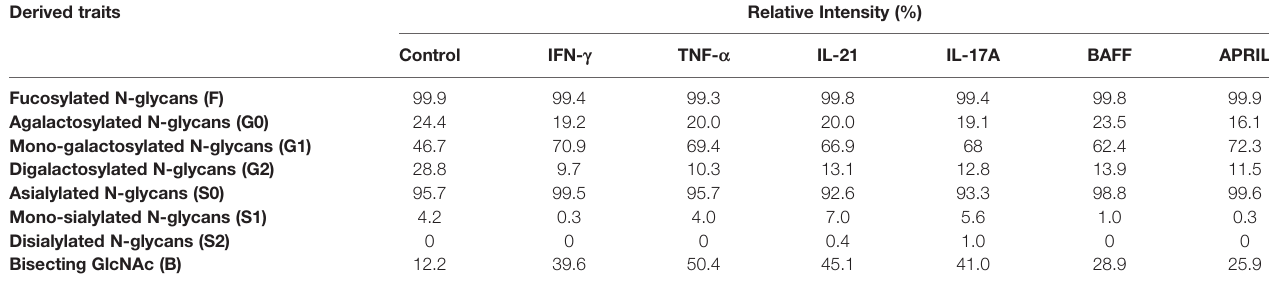
TABLE 4 | Relative intensity of derived glycosylation traits. Derived